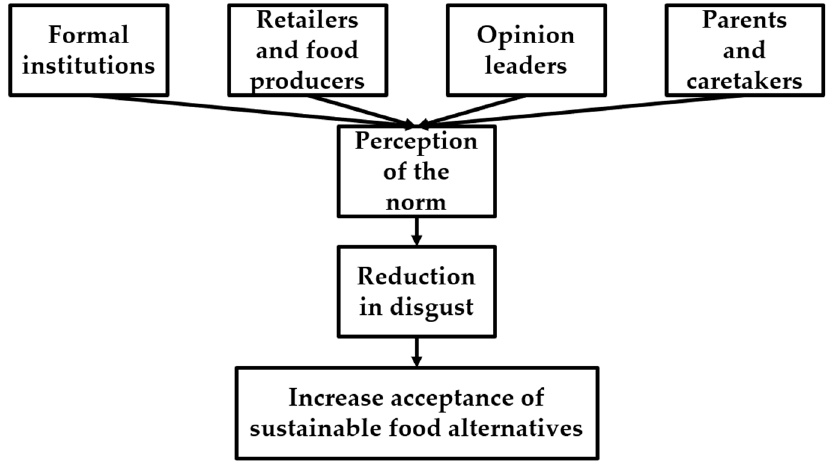
Figure 1. Public exposure therapy visualized. Different parties can affect the perception of the norm, thereby reducing disgust, and eventually increasing the acceptance of sustainable food alternatives.